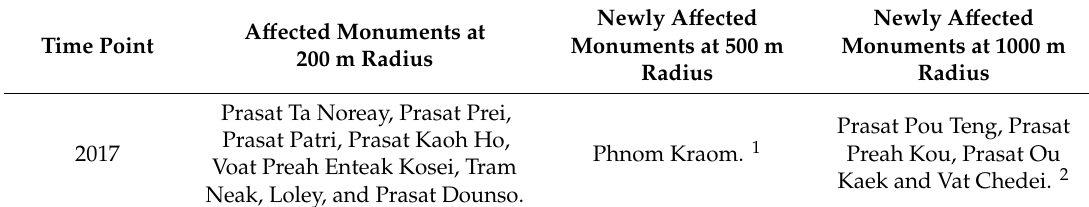
Table 3. List of a ff ected monuments in 2017.